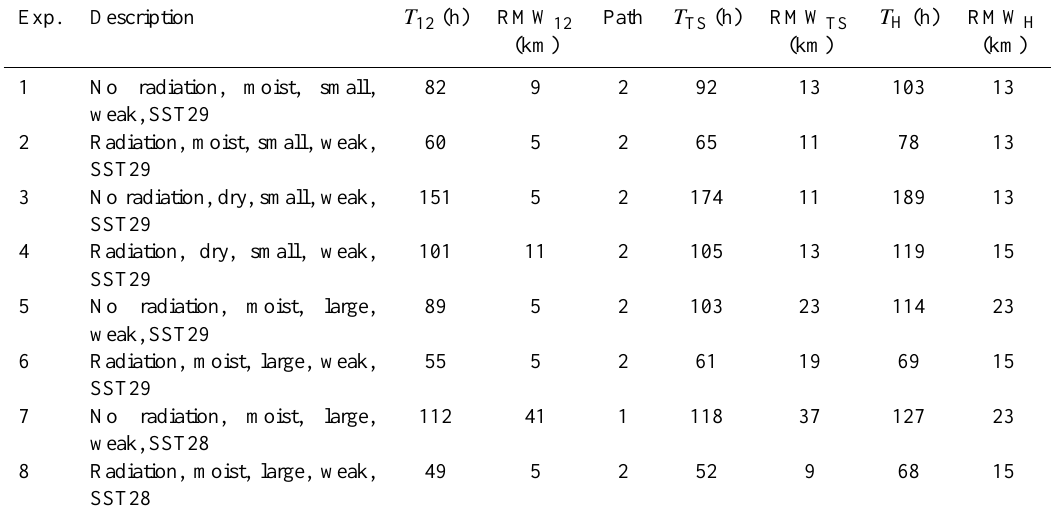
Table 1. General statistics comparing four cases without and with radiation from NM13. Moist, dry refers to the core having an initial moisture anomaly or not. All cases are for a weak initial vortex having a maximum tangential wind speed of 8ms − 1 at z = 4km. Shown are the time the maximum averaged tangential wind speeds at the surface reach 12ms − 1 ; the near-surface radius of maximum winds (RMW) at this time; the pathway taken to genesis; the time at which the system becomes a tropical storm (TS); the RMW at this time; the time the system becomes a hurricane (H); and the RMW at this time.